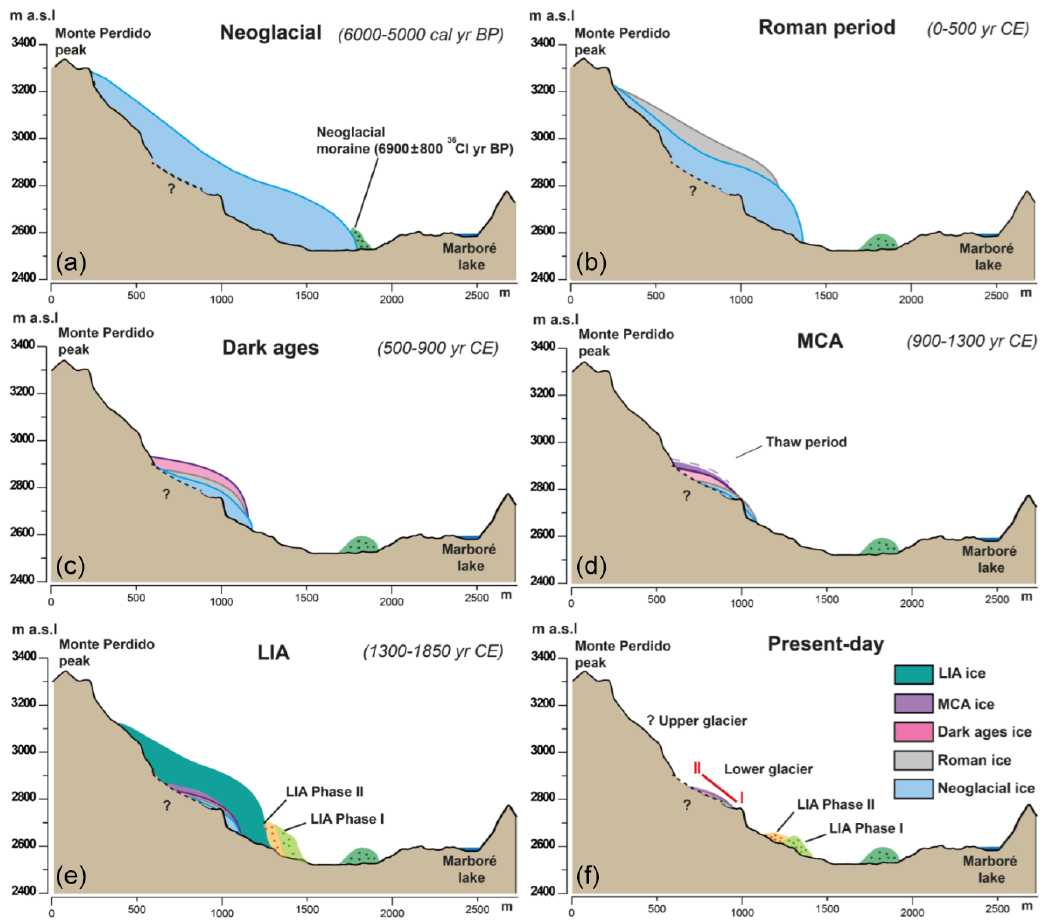
Figure 5. Schematic geomorphic transects (south to north) taken from the Marboré Cirque, showing the tentative reconstruction of MPG during the six main stages discussed in the text. (a) Neoglacial Period (ca. 5000–6000cal years BP) where the Neoglacial moraine is indicated (García-Ruiz et al., 2014). This figure represents the state of maximum glacier advance during the Neoglacial period. (b) Roman period (0–500CE) when the glacier is shown to have considerably retreated. (c) Dark Ages (500–900CE). (d) Medieval Climate Anomaly (900– 1300CE), a period when the glacier retreated and ablation caused a concentration of debris and from which organic remains form dark layers in the glacier ice (discontinuous line aims to highlight the importance of melting processes). (e) Little Ice Age (1300–1850CE), with MPG reaching the LIA moraines’ position, thus represented at its maximum advance during that period. (f) Present-day situation characterised by MPG divided into two ice bodies, no ice remaining from the LIA and very steep slopes (sampling transect indicated by a red